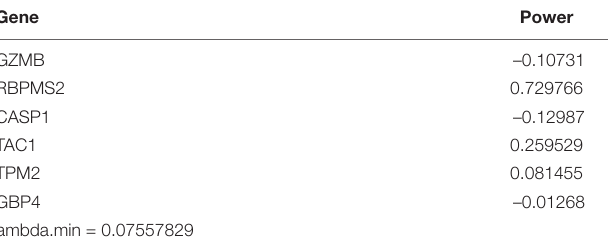
TABLE 1 | Pyroptosis-related signature score